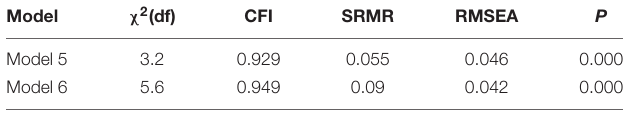
TABLE 5 | Model fitting metrics.